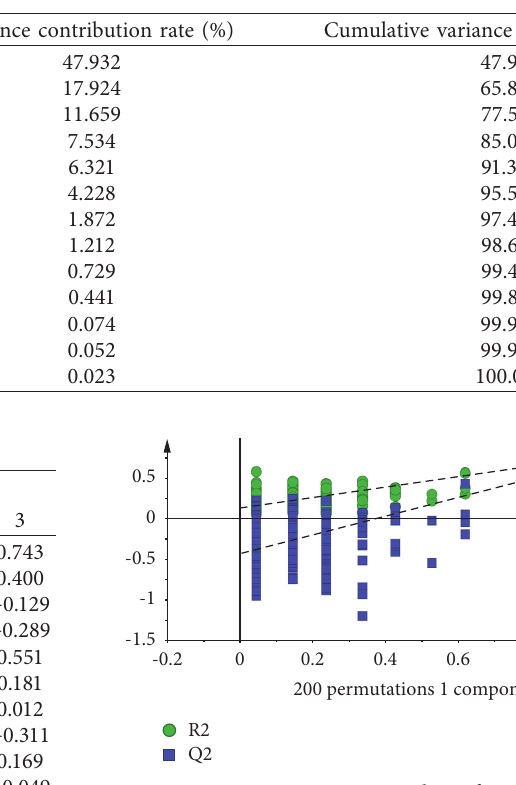
Table 3: Eigenvalue and variance cumulative contribution rate.